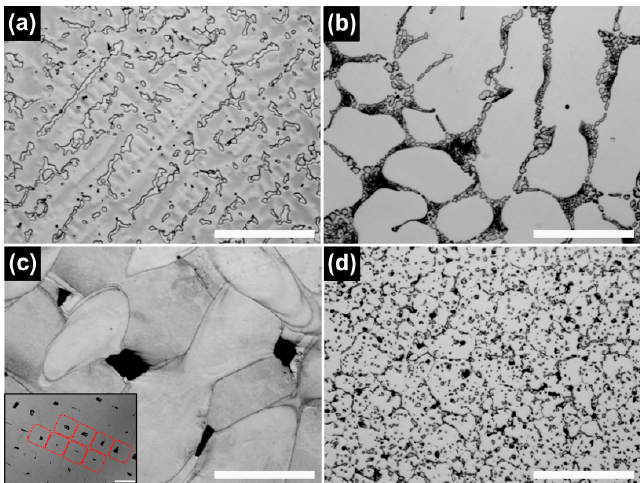
Figure 2. Optical microscopy images of the Co-Cr alloys tested. ( a ) CS; ( b ) ML; ( c ) SLM; and ( d ) ML/PS (200×, scale bar = 100 μ m). The red rounded squares in the small box in C indicate laser scan traces (small box in C: 100×, scale bar = 100 μ m).